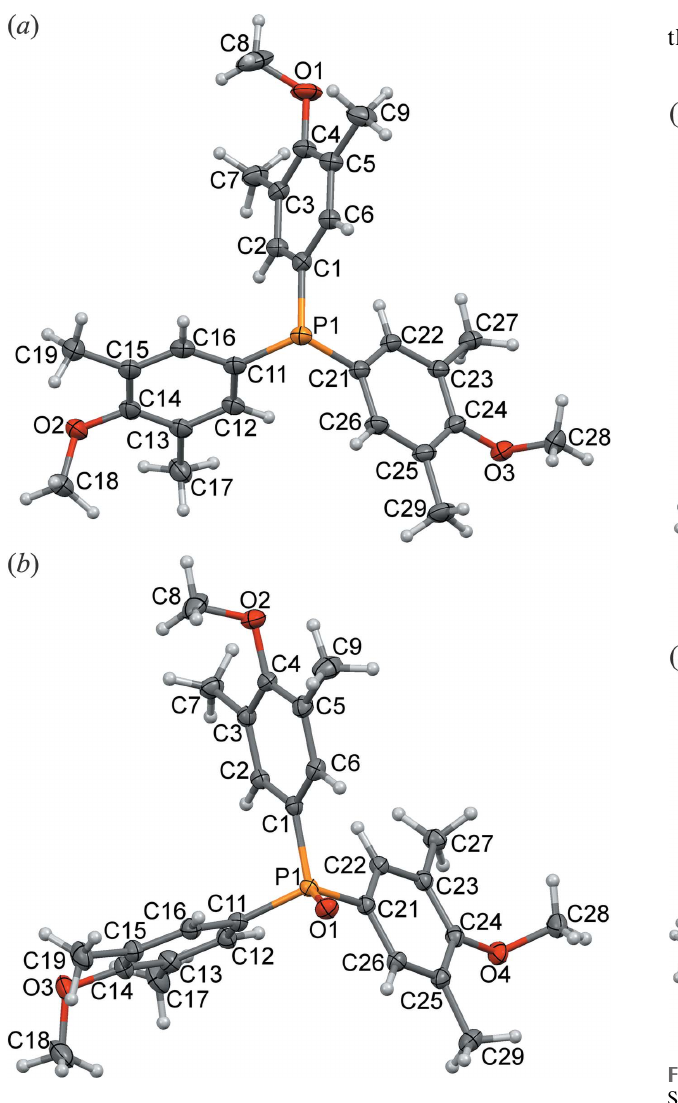
Figure 2 Displacement ellipsoid plots (50%) of ( a ) phosphine (III) and ( b ) phosphine oxide (IV), including the atom-numbering